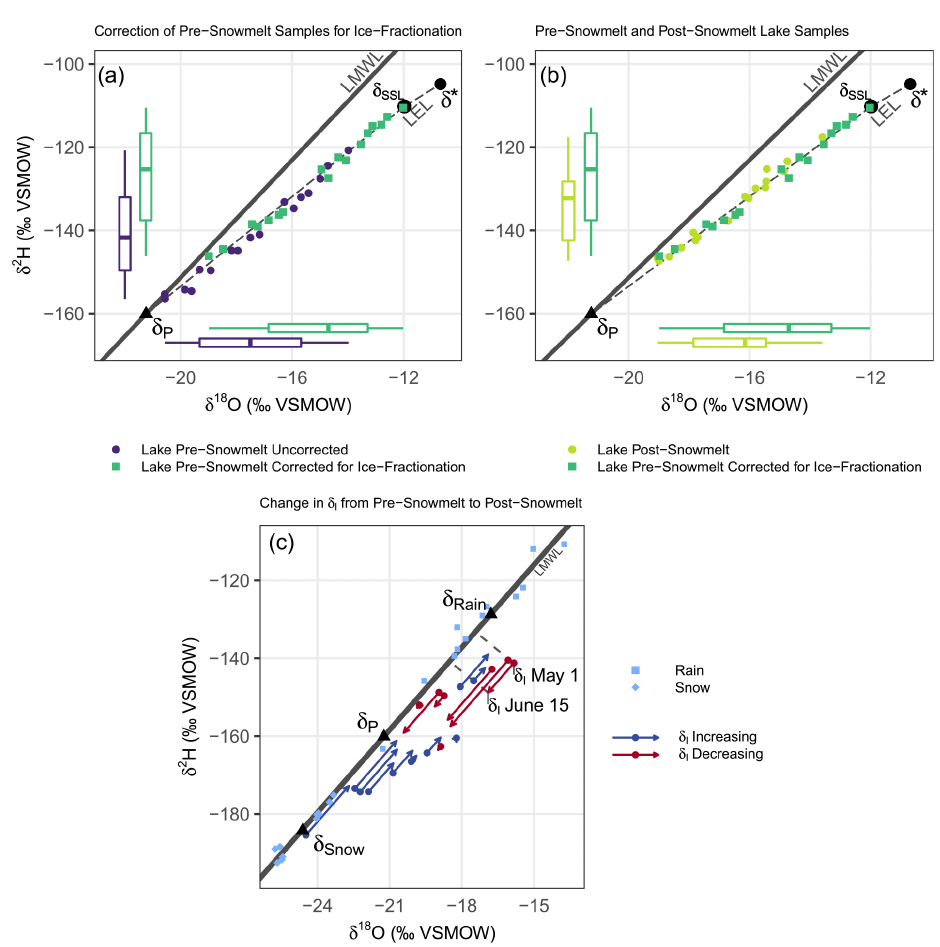
Figure 5. Lake water and precipitation isotope data are displayed on δ 18 O– δ 2 H graphs. The local meteoric water line (LMWL: δ 2 H = 7 . 1 · δ 18 O − 10 . 0) is indicated by the solid line, while the LEL ( δ 2 H = 5 . 2 · δ 18 O − 48 . 9) is indicated by the dashed line. δ P represents the average value of precipitation in the region, based on 2018 sampling of end-of-winter snow and rainfall from April to September. δ SSL is the point at which evaporation and inflow are equal ( E/I = 1). (a) Uncorrected and corrected for ice fractionation pre-snowmelt lake water isotope data. (b) Corrected pre-snowmelt and post-snowmelt data. (c) The shift in δ I from pre-snowmelt to post-snowmelt, as indicated by a circle for pre-snowmelt δ I values and the end of the arrow for post-snowmelt δ I values. All δ I values are offset from the LMWL for visibility, as all δ I values are constrained to the